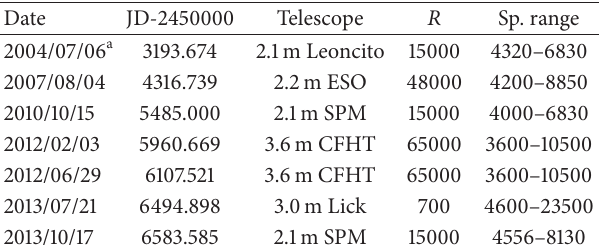
Table 1: Spectroscopic observations of MWC 930 in 2004–2013.